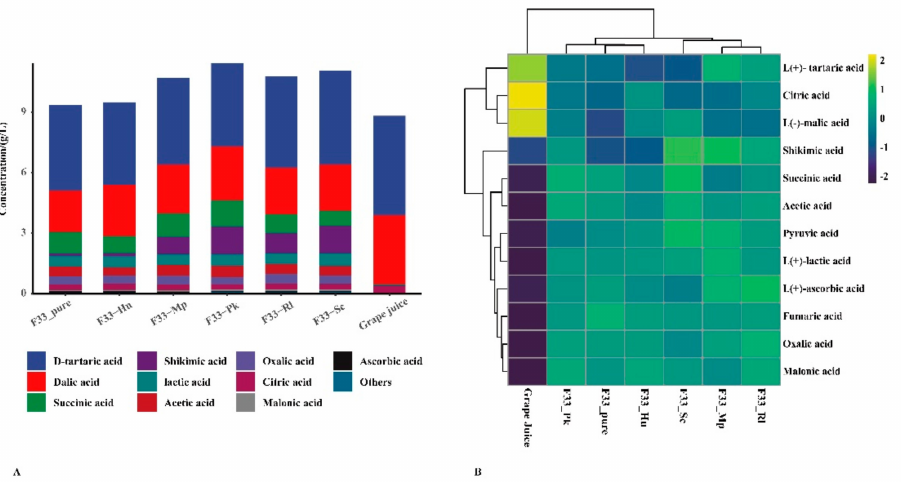
Figure 3. The distribution of organic acids content under different fermentation strategies. ( A ) Stacked graph. ( B ) Clustering